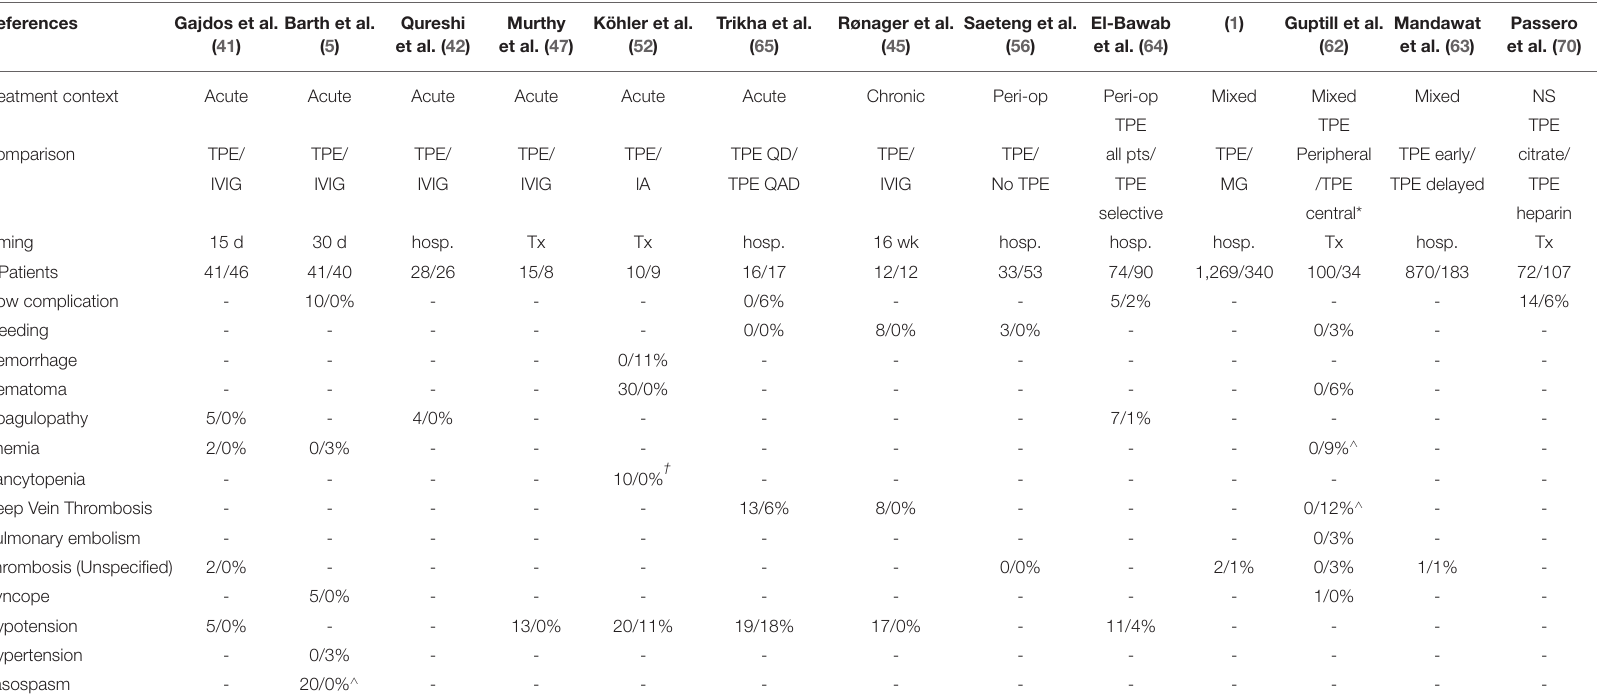
TABLE 8 | Comparative vascular adverse event data for TPE in